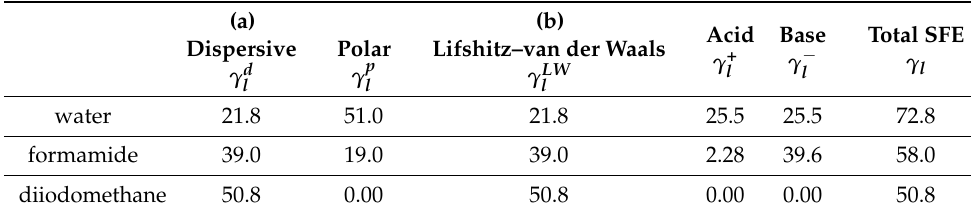
Table 3. Surface free energy components (mJ/m 2 ) of probe liquids used for calculation using (a) Wu and Owens–Wendt models and (b) acid–base